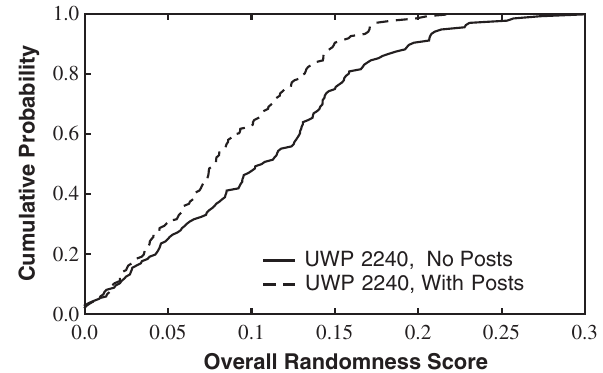
FIG. 10. Cumulative probability distribution of the overall defined in Eq. (6)] for two distinct randomness score [ R total populations of students enrolled in UWP 2240. One population was not required to post comments to the problems while the other was required to post one comment per week. An identical set of 136 statements was used to create the distribution for each